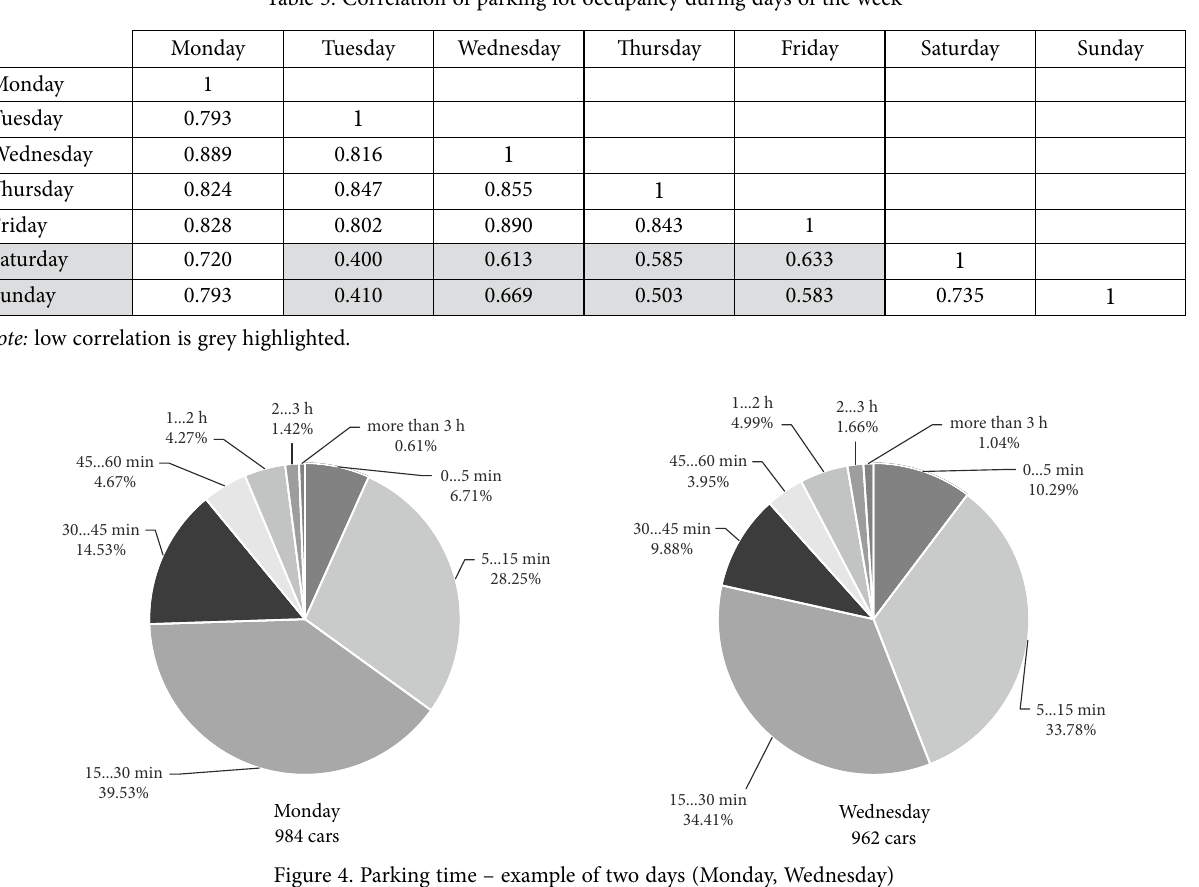
Table 3. Correlation of parking lot occupancy during days of the week